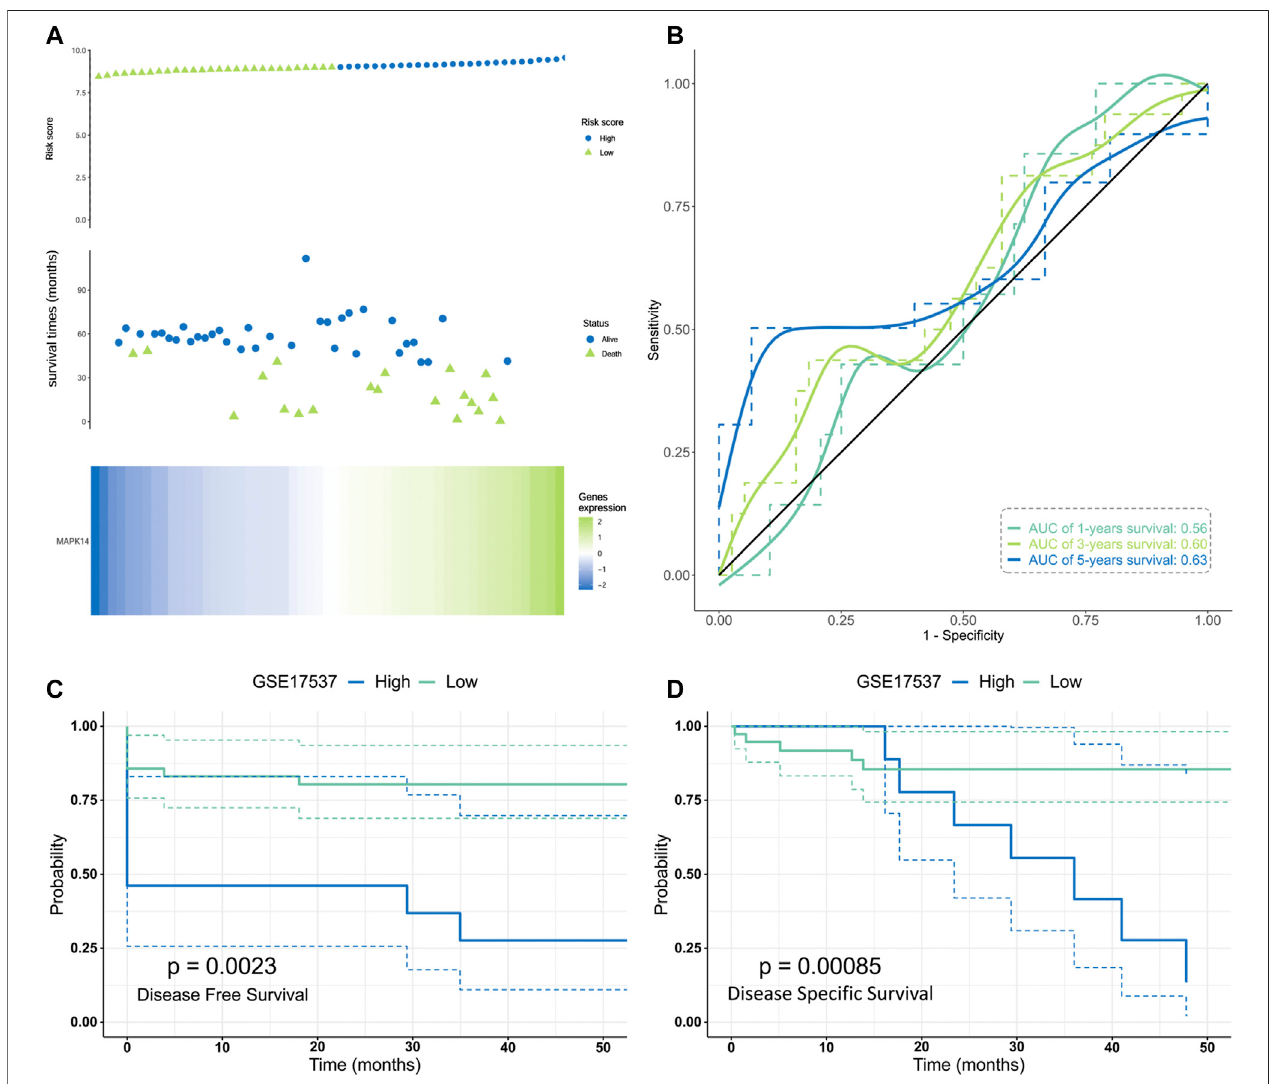
FIGURE 3 | Validation of the risk model in the GES17537 cohort. (A) Distribution, survival time and survival status of CRC patients and Mapk14 gene expression in the GSE17537 cohort based on median risk score. (B) ROC curve and AUC of Mapk14 gene. (C – D) Kaplan-Meier curves for the DFS/DSS of patients in the high- and low-risk groups.